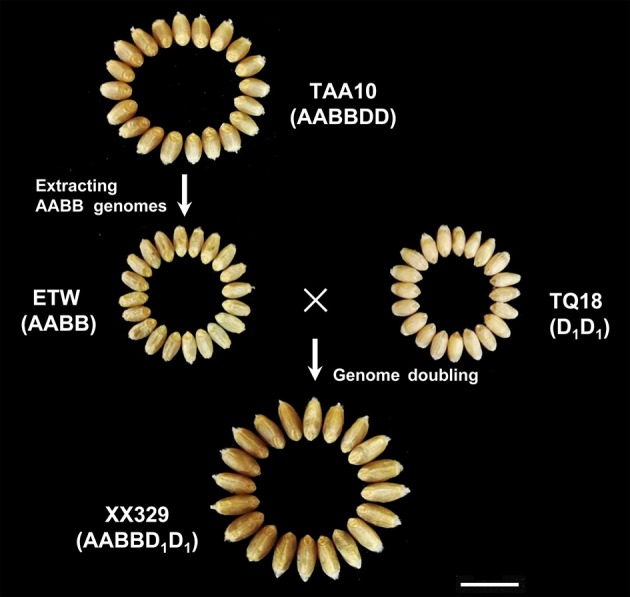
Grain morphology of the common allohexaploid wheat TAA10, the extracted allotetraploid wheat ETW, the Ae. Tauschii line TQ18 and the resynthesized allohexaploid wheat XX329. The scale bar represents 1 cm.